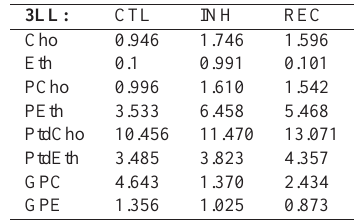
Table 4: Average concentrations of 3LL carcinoma tumor metabolites